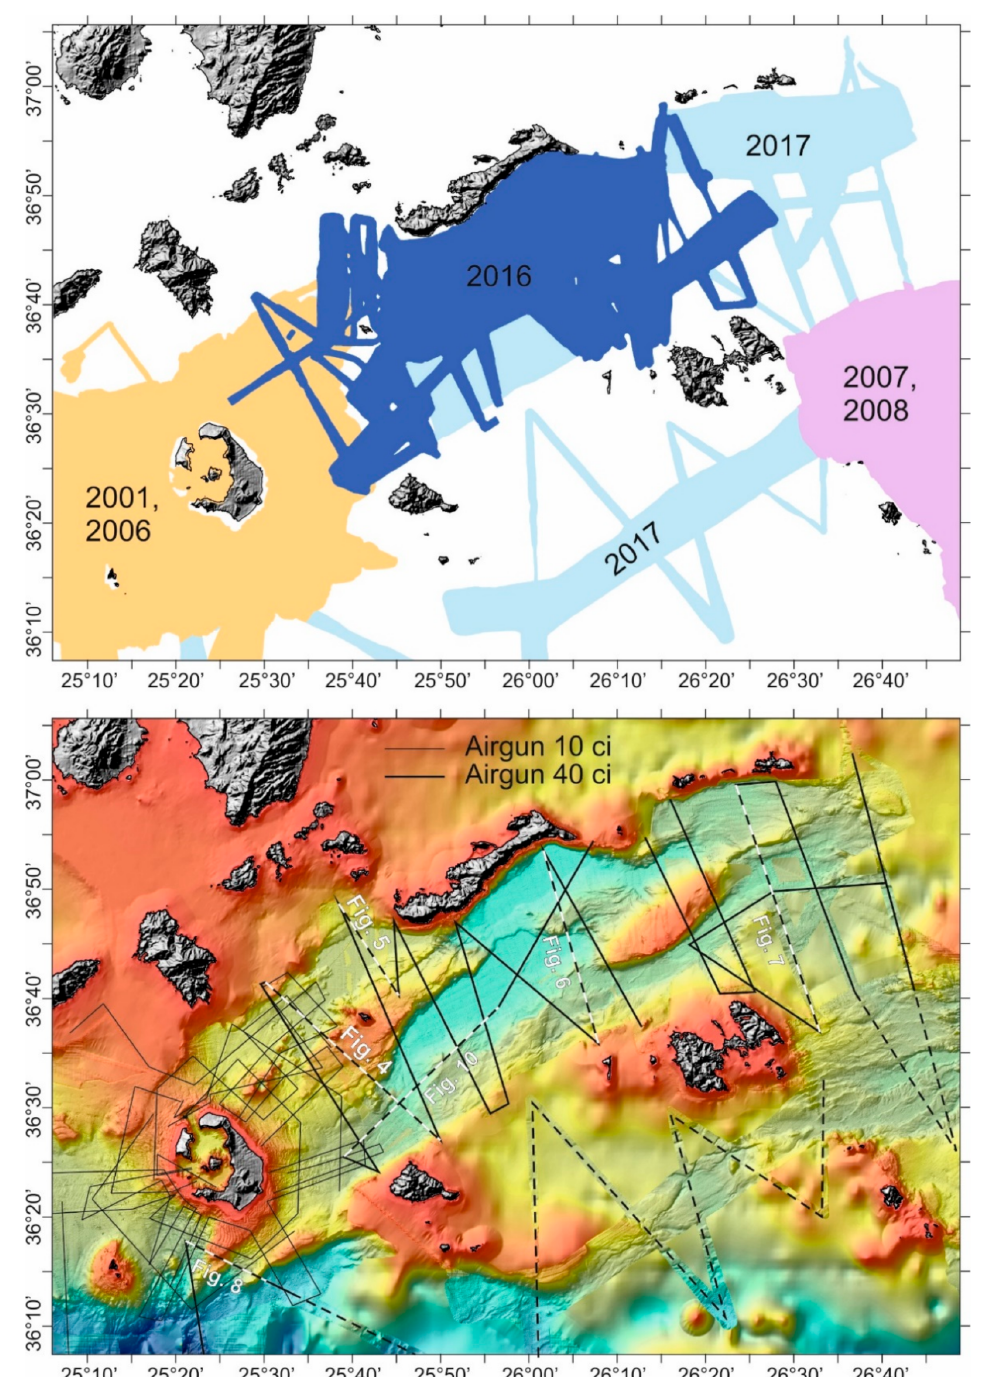
Figure 3. Left: Swath bathymetry coverage and year of acquisition. Right: Swath bathymetry map of the study area showing the location of the airgun 10 ci and 40 ci seismic lines acquired in the study area. Dashed white and black lines show the seismic lines described in the